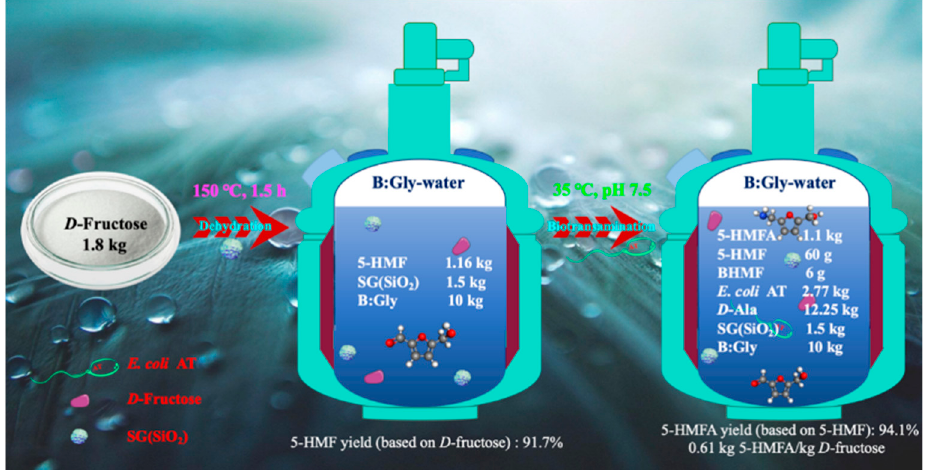
Figure 9. Mass balance from biobased D -fructose to 5-HMFA in B:Gly-water. Chemo-catalysis and bio-catalysis approaches have been used in the synthesis of 5-HMFA [5,40]. 5-HMFA formed in a 4.3% yield from furfurylamine with HCl (6 M) in a formaldehyde solution (35 wt%) at 30 °C after 15 min [40]. Furfurylamine was aminated to 5-HMFA (15% yield) by Amberlyst-15 and formalin at 40 °C after 1 h [41]. Ru/C, Pd/C and Pt/C could catalyze 5-HMF into 5-HMFA with yields of 40.5%, 57.5% and 81.2% under high pressure, respectively [5]. The production of 5-HMFA by the chemo-catalysis technique suffered from several drawbacks, such as unfriendliness, low yield, poor